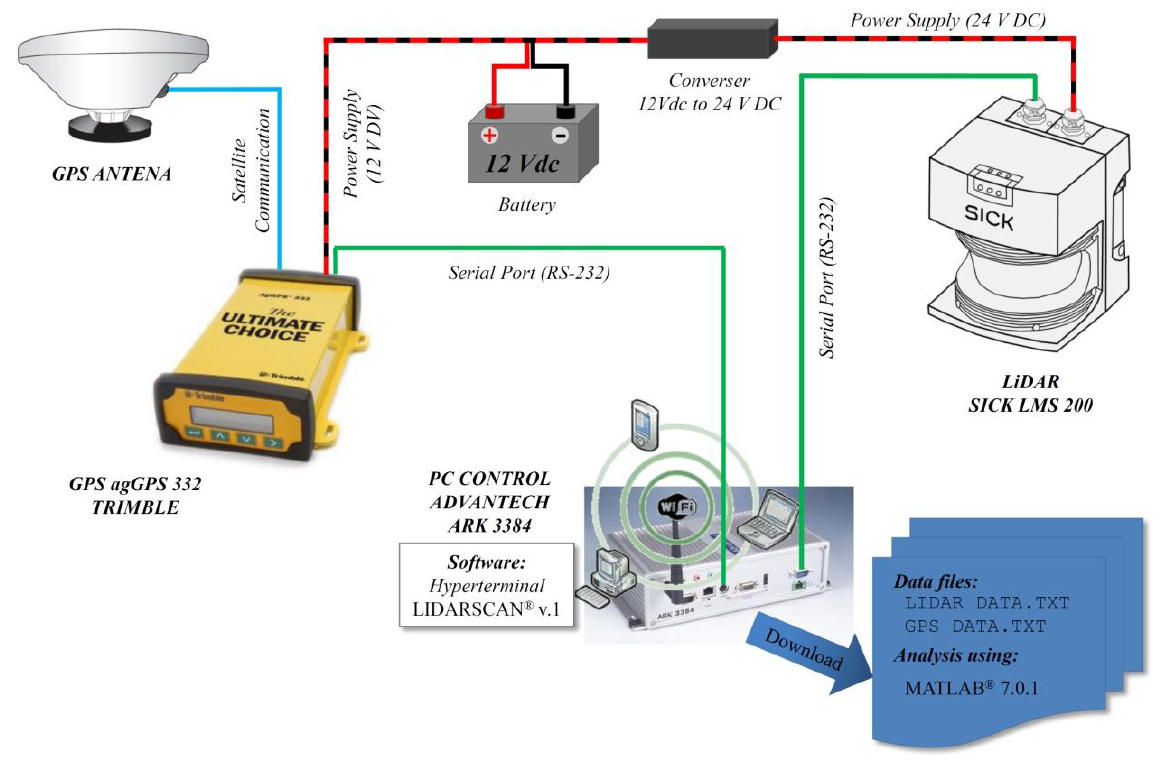
Figure 3. LiDAR, GPS receiver and computer. Scheme of communication.